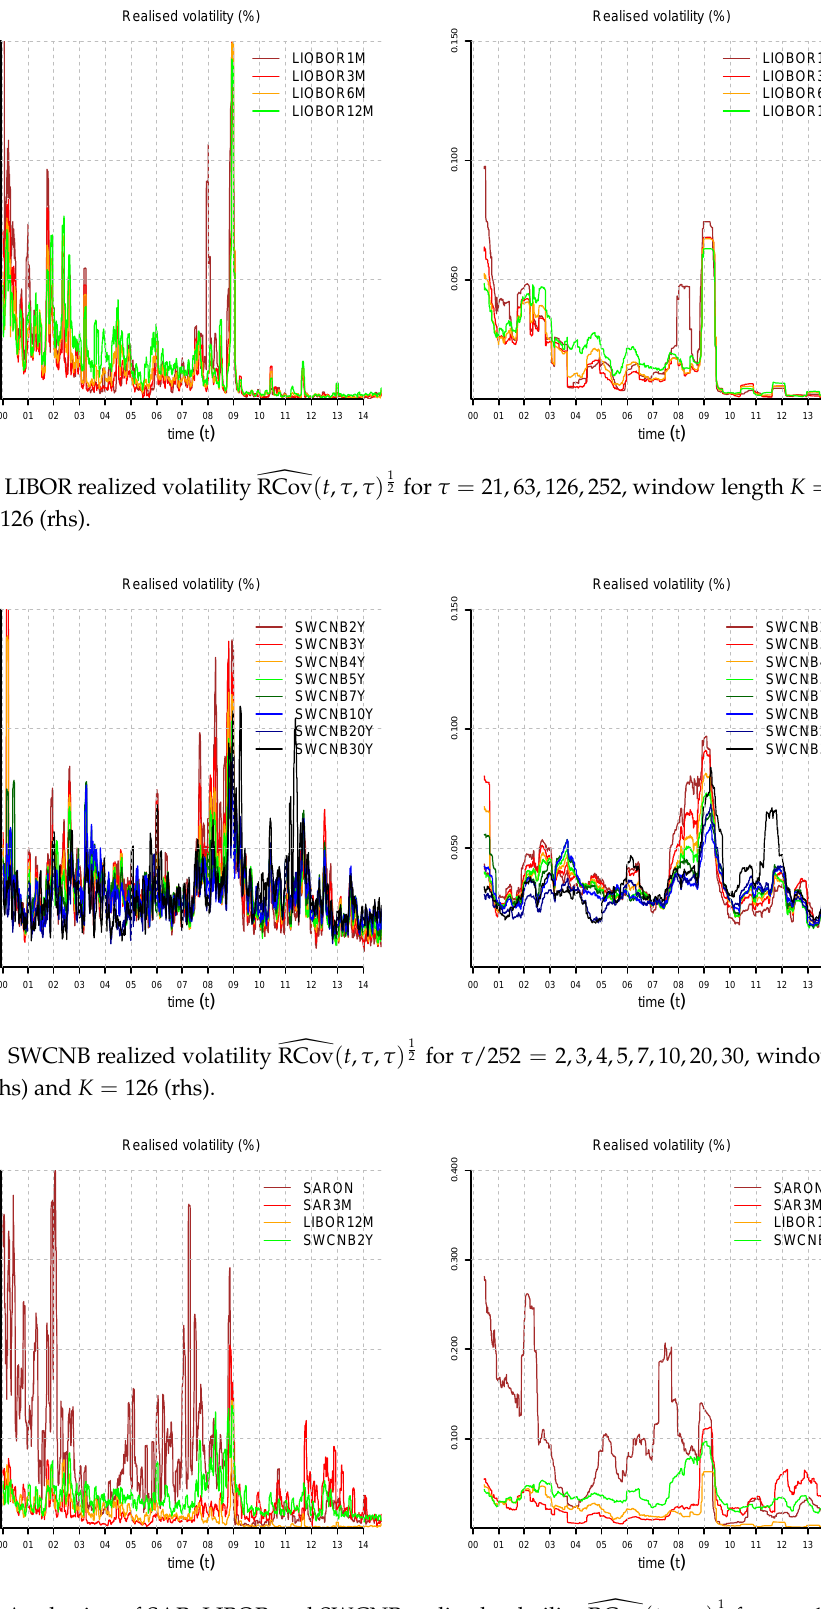
Figure 6. A selection of SAR, LIBOR and SWCNB realized volatility 504, window length K = 21 (lhs) and K = 126 (rhs). Note that LIBOR looks rather differently from SAR and SWCNB after the financial crisis of